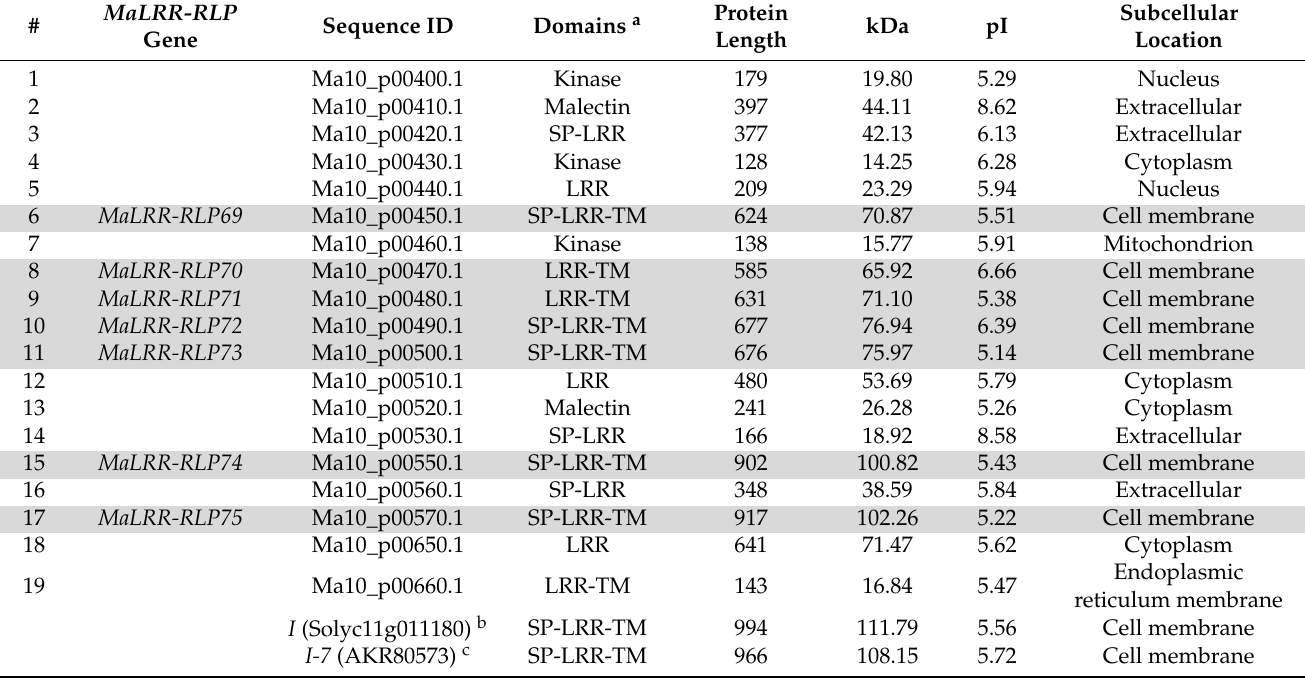
Table 2. Seven MaLRR-RLP genes proposed as Foc race 1 RGCs in the present study (highlighted in gray). These seven Foc race 1 RGCs were located near the distal part of chromosome 10